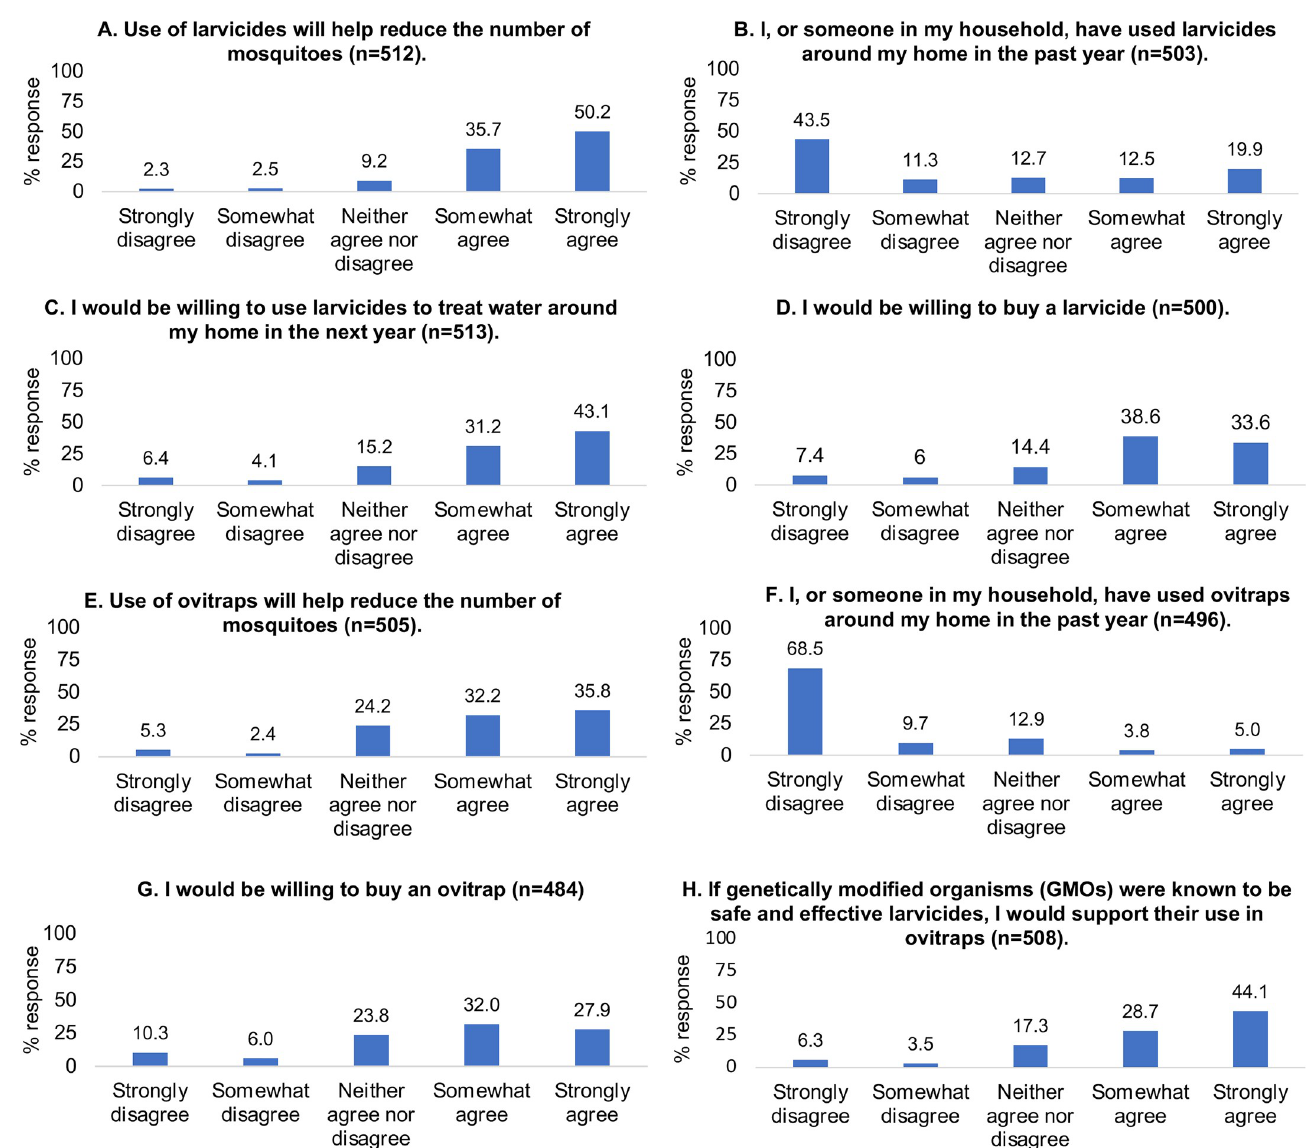
Fig 4. Paper survey respondents’ mosquito control practices and perceptions. A summary of responses to eight questions pertaining to larvicides and ovitraps is presented.